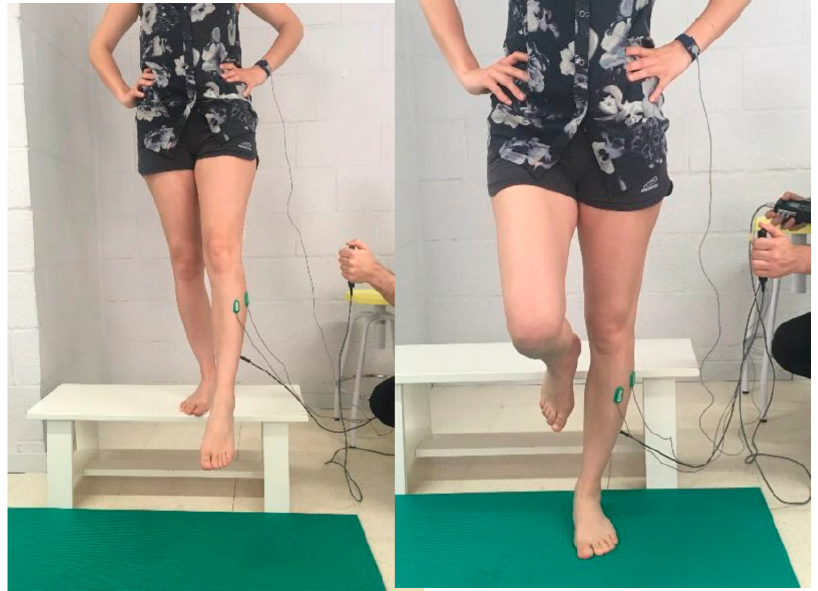
Figure 2. Landing maneuver.